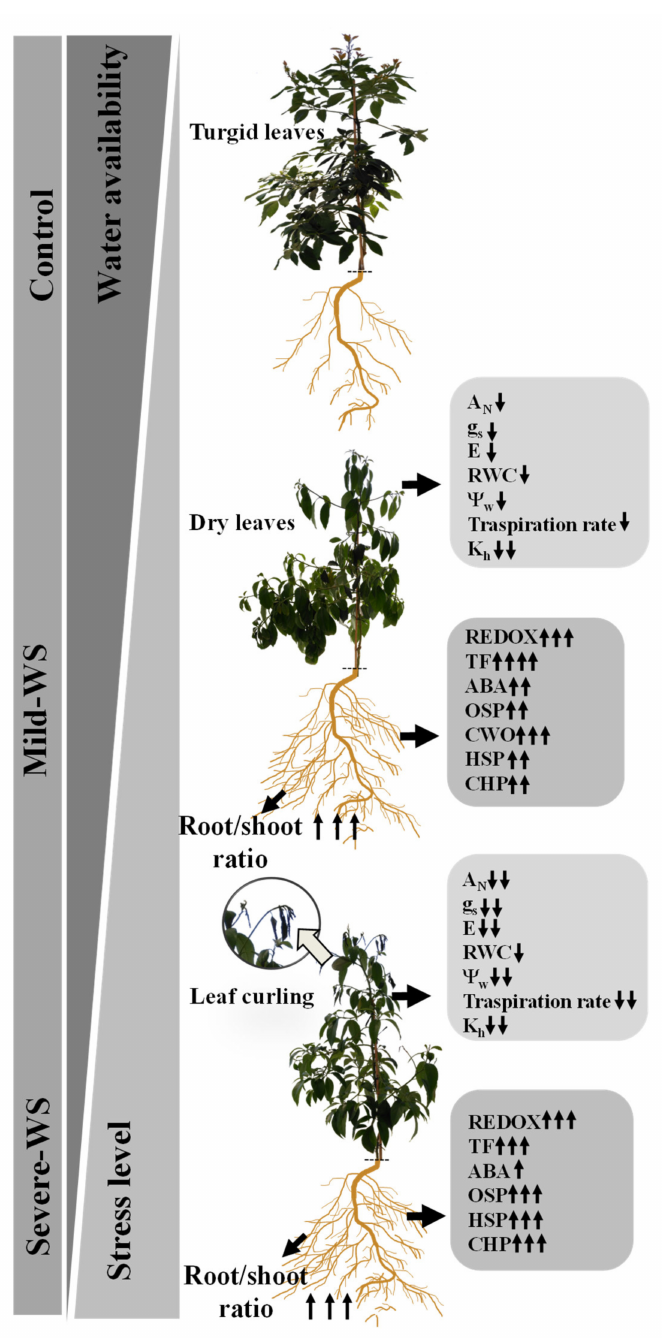
Figure 7. Comparative response of ‘Dusa’ avocado rootstock subjected to two different levels of water stress: mild-WS (50% of Fc) and severe-WS (25% of Fc). Physiological response to the different levels of water stress are represented with changes in net CO 2 assimilation rate ( A N ), stomatal conductance ( g s ), transpiration rate (E), relative water content (RWC), leaf water potential ( Ψ w ), plant transpiration rate, and plant hydraulic conductance (K h ). At a molecular level, mild and severe-WS treatment trigger the overexpression of genes encoding detoxification enzymes (REDOX), transcription factors (TFs), abscisic acid pathway (ABA), osmoprotectants (OSP), cell-wall organization (CWO), heat-shock proteins (HSPs), and chaperones